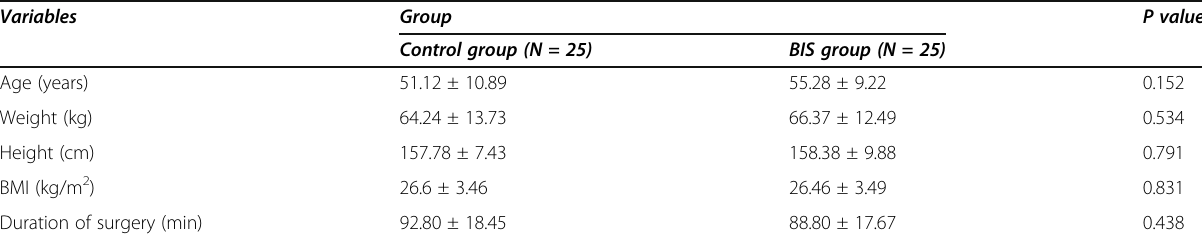
Table 1 Demographic data comparison